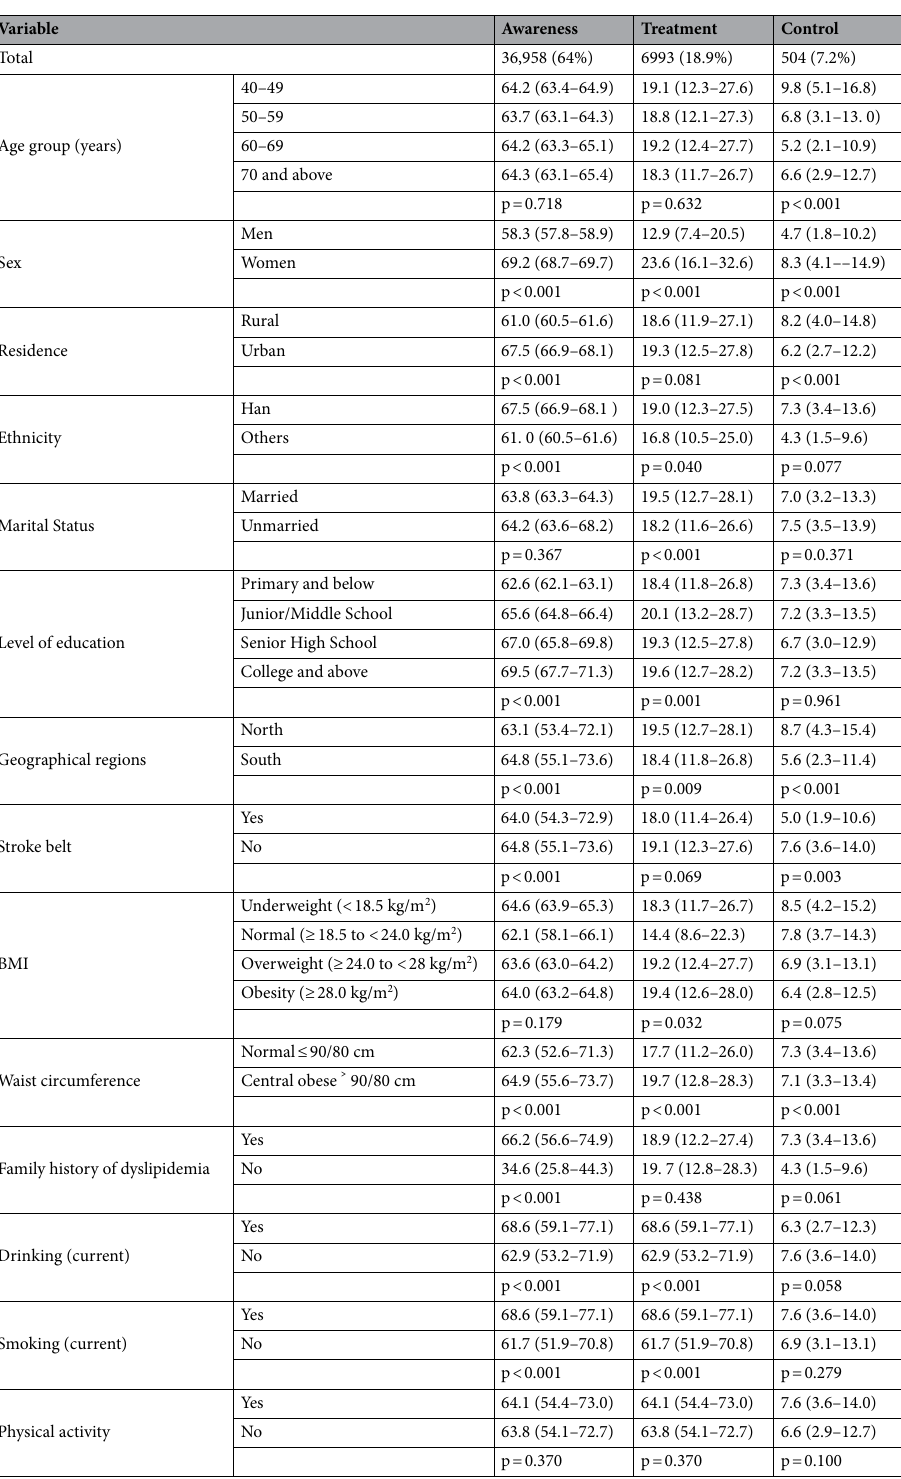
Table 2. Awareness, treatment, and control of dyslipidemia among subjects. Proportion in each column has been calculated using the values in previous column as a denominator, unmarried